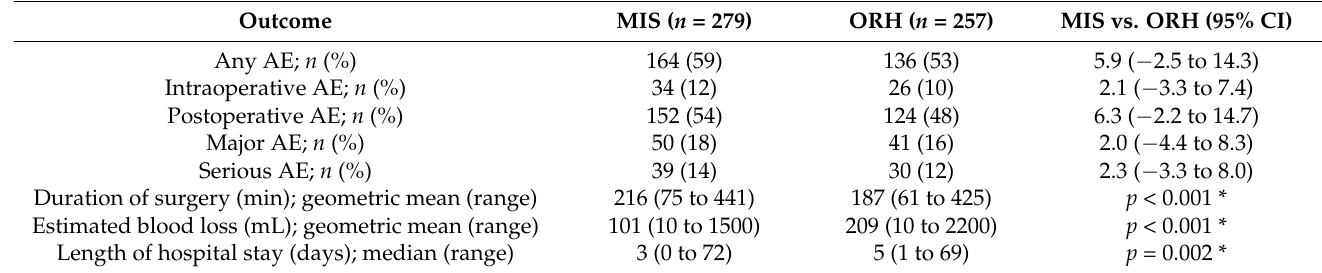
Table 3. LACC trial—Adverse events.